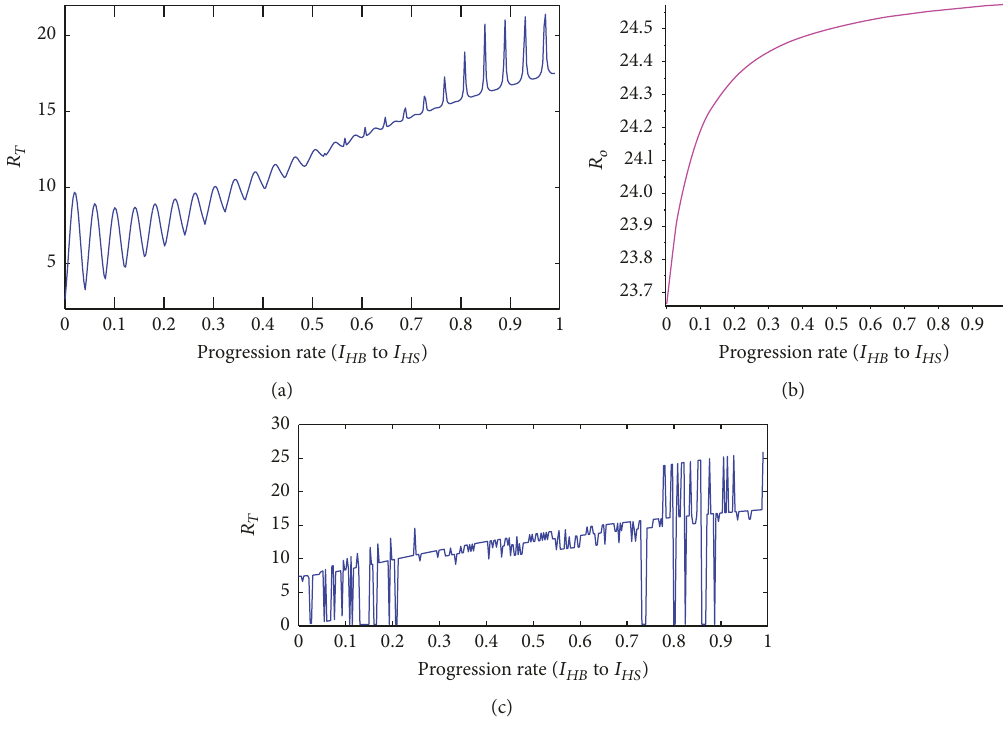
Figure 1: Effect of progression rates from 𝐼 𝐻𝐵 to 𝐼 𝐻𝑆 on the periodic reproduction